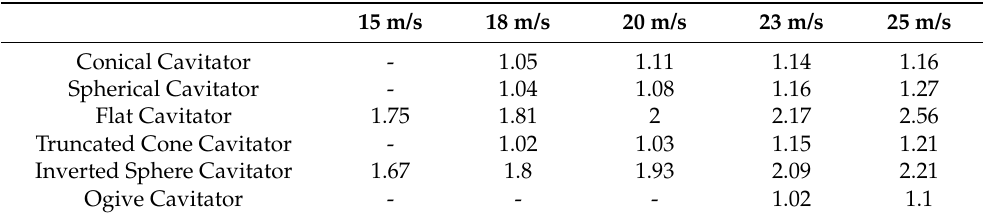
Table 1. The measured bubble length (in multiplies of body diameter) for different cavitators and motion speeds (the sign (-) indicates no bubble existence). 15 m/s 18 m/s 20 m/s 23 m/s 25 m/s Conical Cavitator - 0.08 0.28 0.6 0.7 Spherical Cavitator - 0.45 0.81 1.39 Flat Cavitator Truncated Cone Cavitator - Inverted Sphere Cavitator